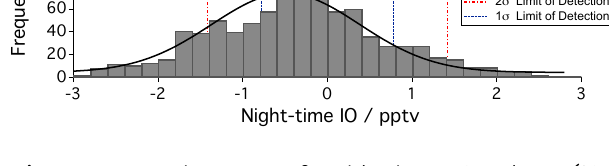
Fig. 7. Histogram of night-time IO data (60s integration time; grey boxes), ± LOD (2 σ = 1.4pptv; red dash-dot lines, 1 σ = 0.78pptv; blue dashed lines). A Gaussian fit to these data (black line) shows a slight negative bias ( −